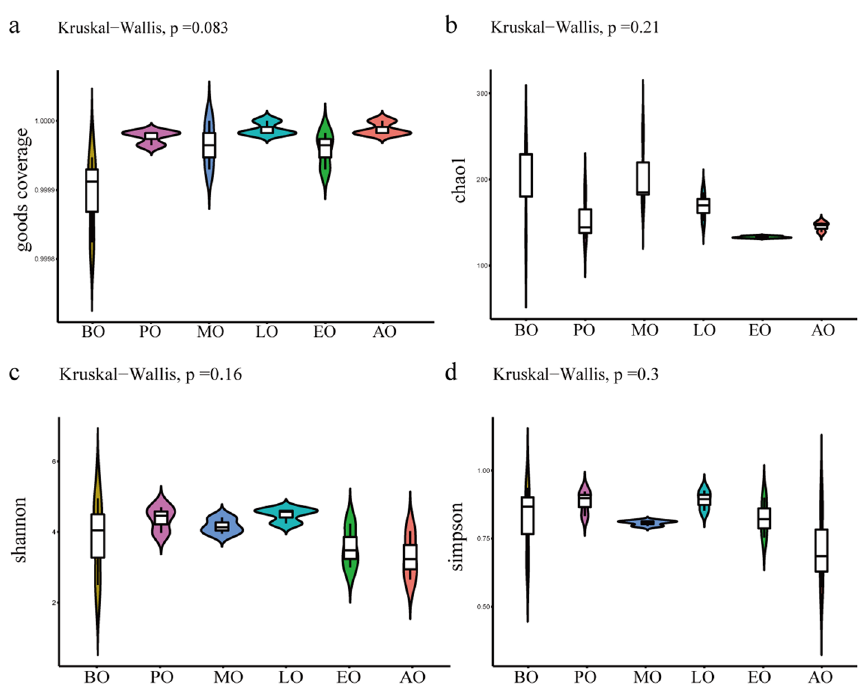
Figure 4. Alpha diversity of gut bacteria in winter honeybees. The amount of bacterial diversity was determined by comparing Goods coverage ( a ), the Chao 1 index ( b ), the Shannon index ( c ), and the Simpson index ( d